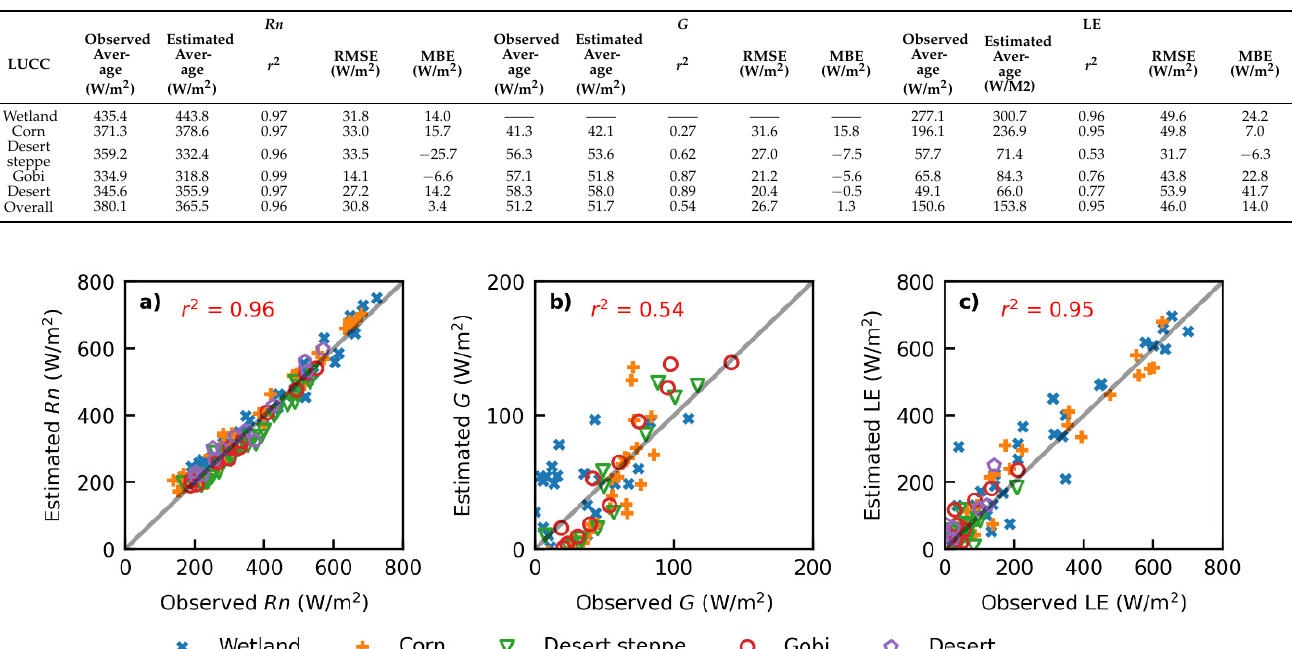
Table 3. Performance of Rn, G , and LE from the WAPT model during long-term observation periods from 2013 to 2018. Rn G LUCC